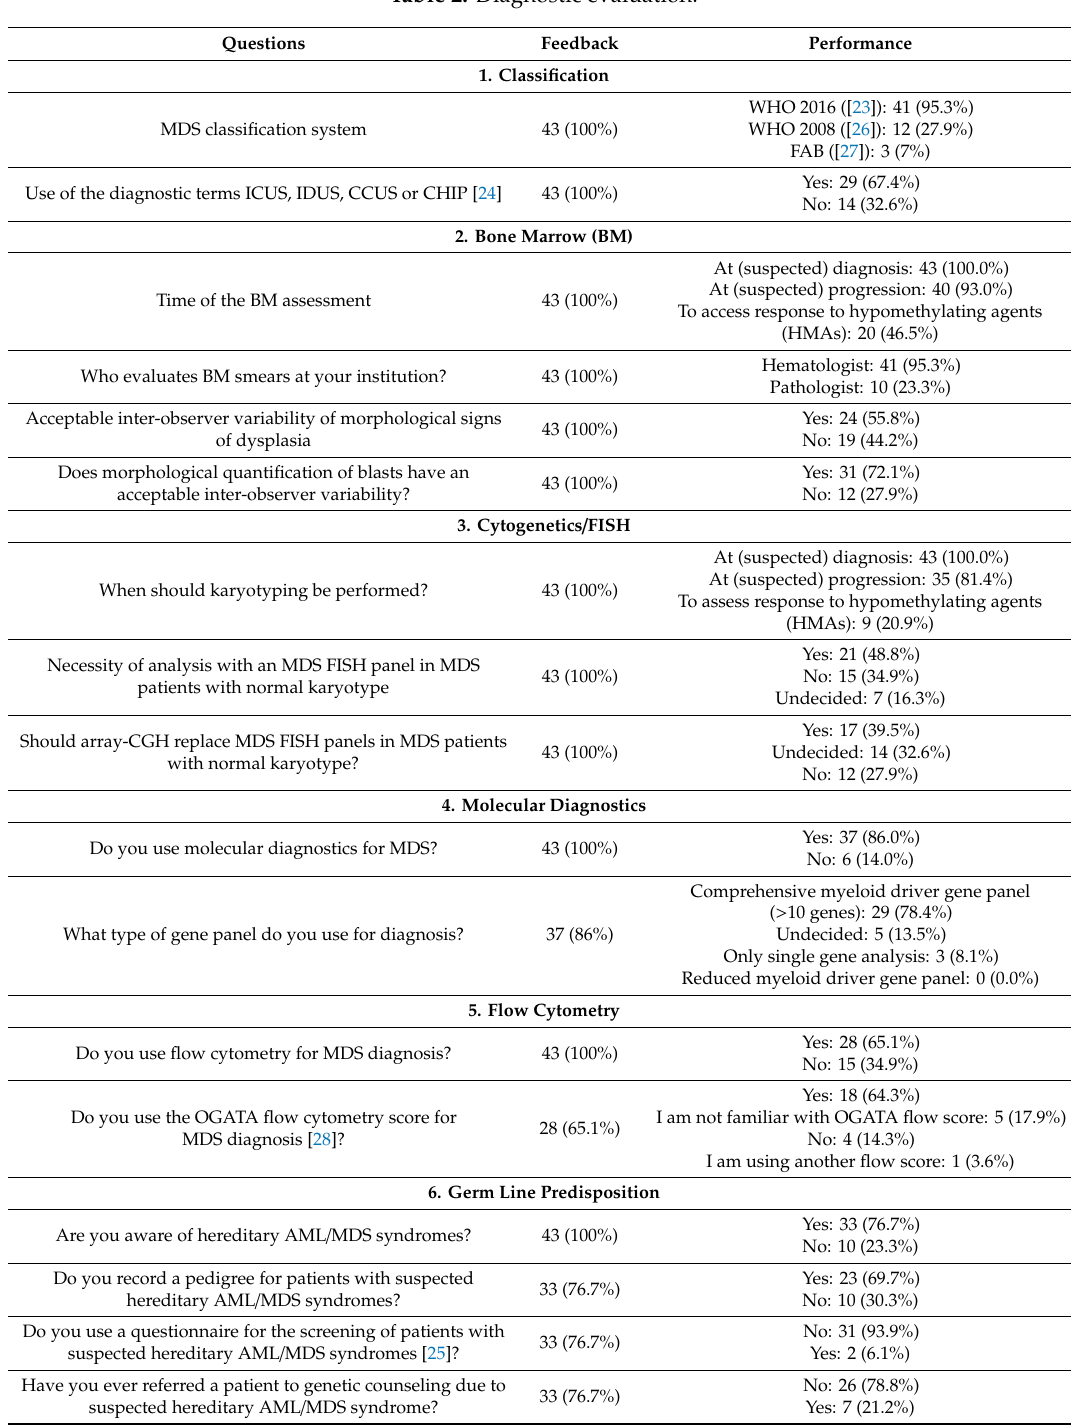
Table 2. Diagnostic